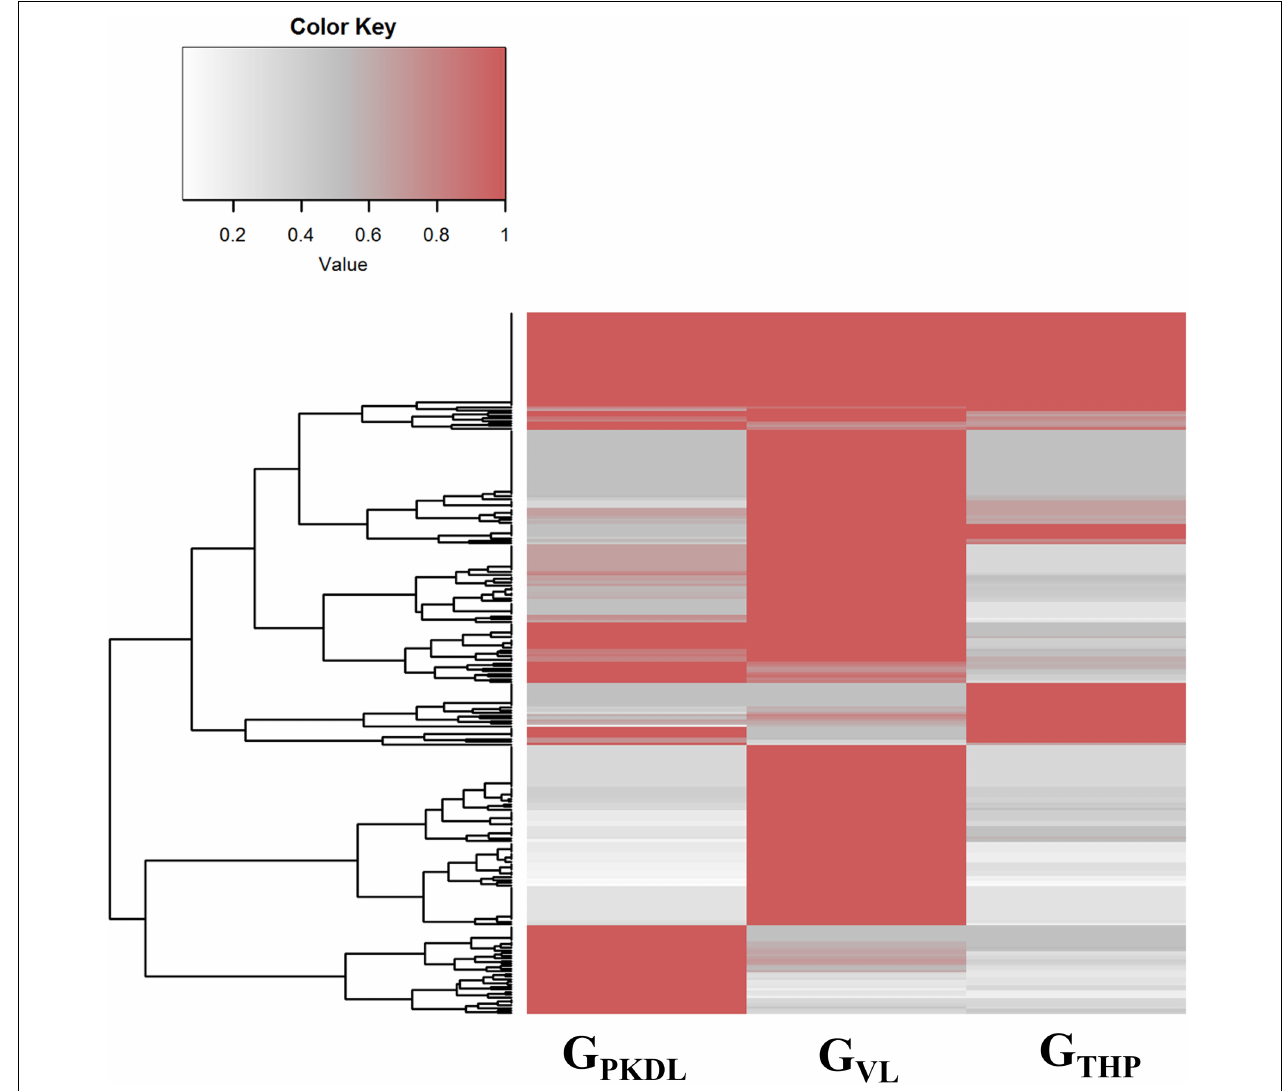
FIGURE 4 | Commonly expressed microRNAs (miRNAs) of G THP (THP-1), G VL [visceral leishmaniasis (VL)], and G PKDL [post-kala-azar dermal leishmaniasis (PKDL)] and their corresponding normalized read